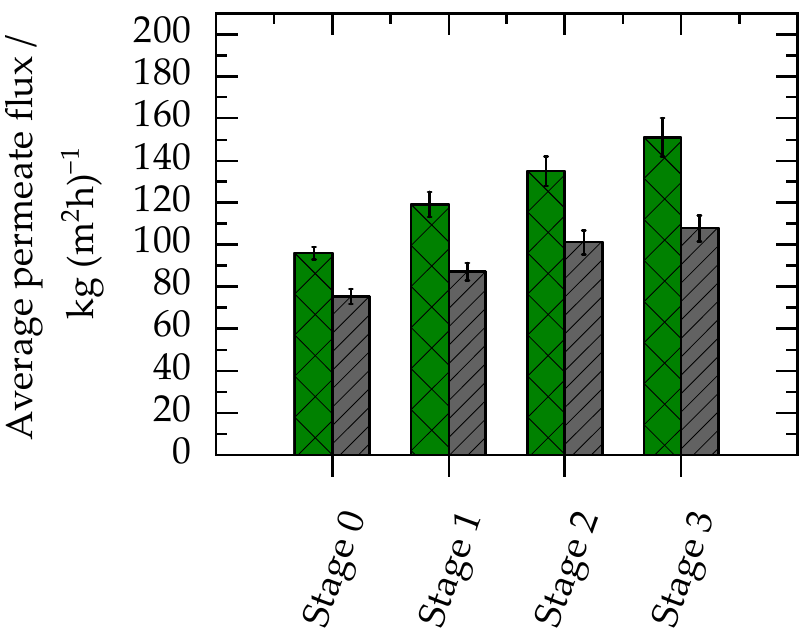
Figure 3. Average permeate flux during discontinuous diafiltration at different stages. During each stage, the initial feed mass is reduced by half, and an equivalent amount of water is added as feed for the next stage. The green crossed bars represent the results for a solution containing 5 wt% ethanol in water, and the grey lined bars show the flux for an aqueous feed containing 0.1 wt% model particles and 5 wt% ethanol (rest water). Experiments were carried out at 30 bar and 25 °C.